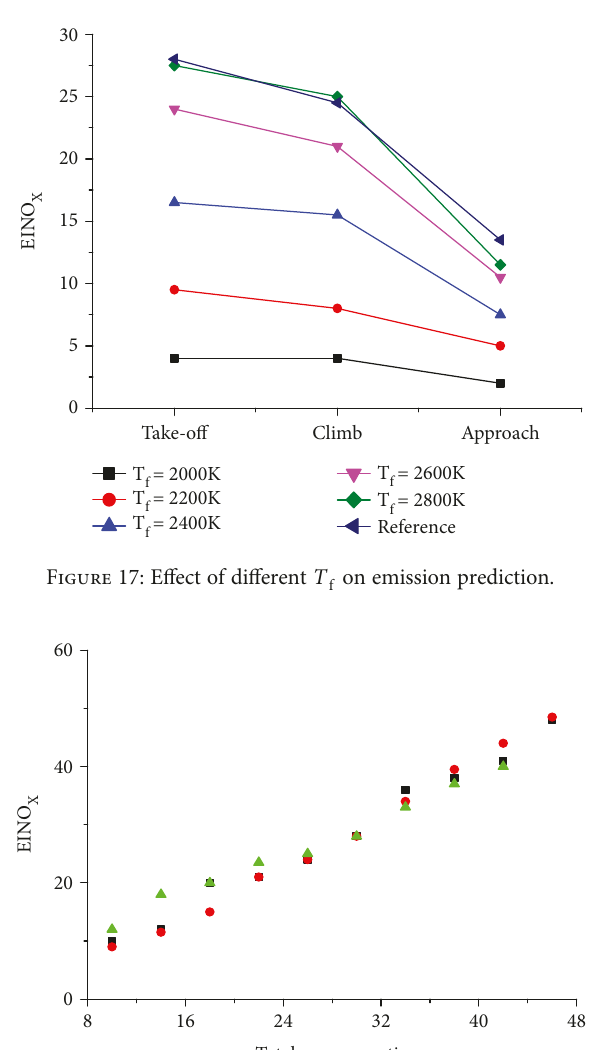
Figure 18: Prediction precision comparison between the methods with ICAO